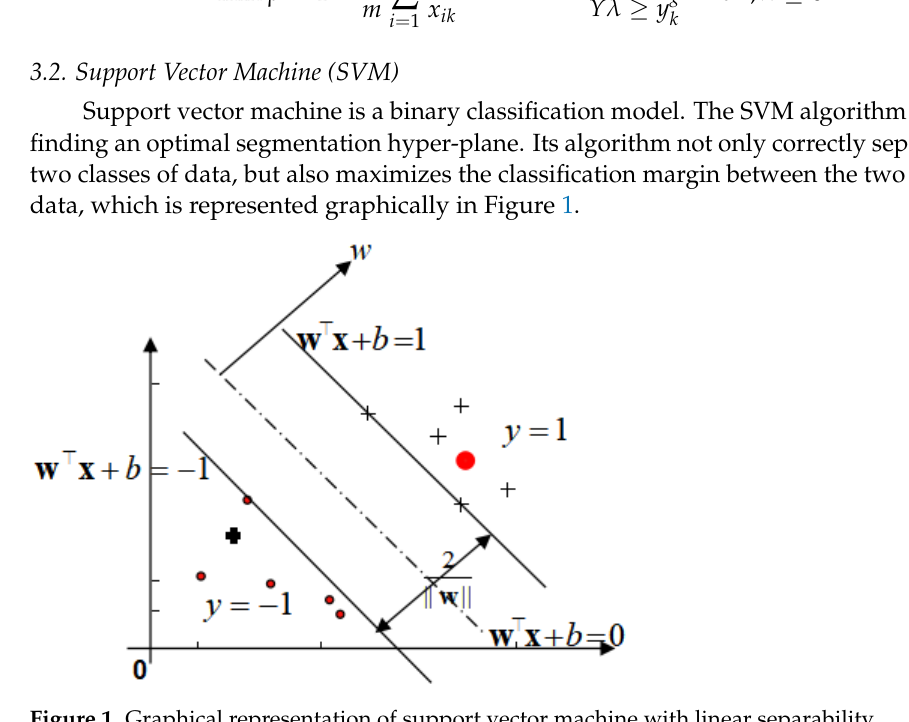
Figure 1. Graphical representation of support vector machine with linear separability.